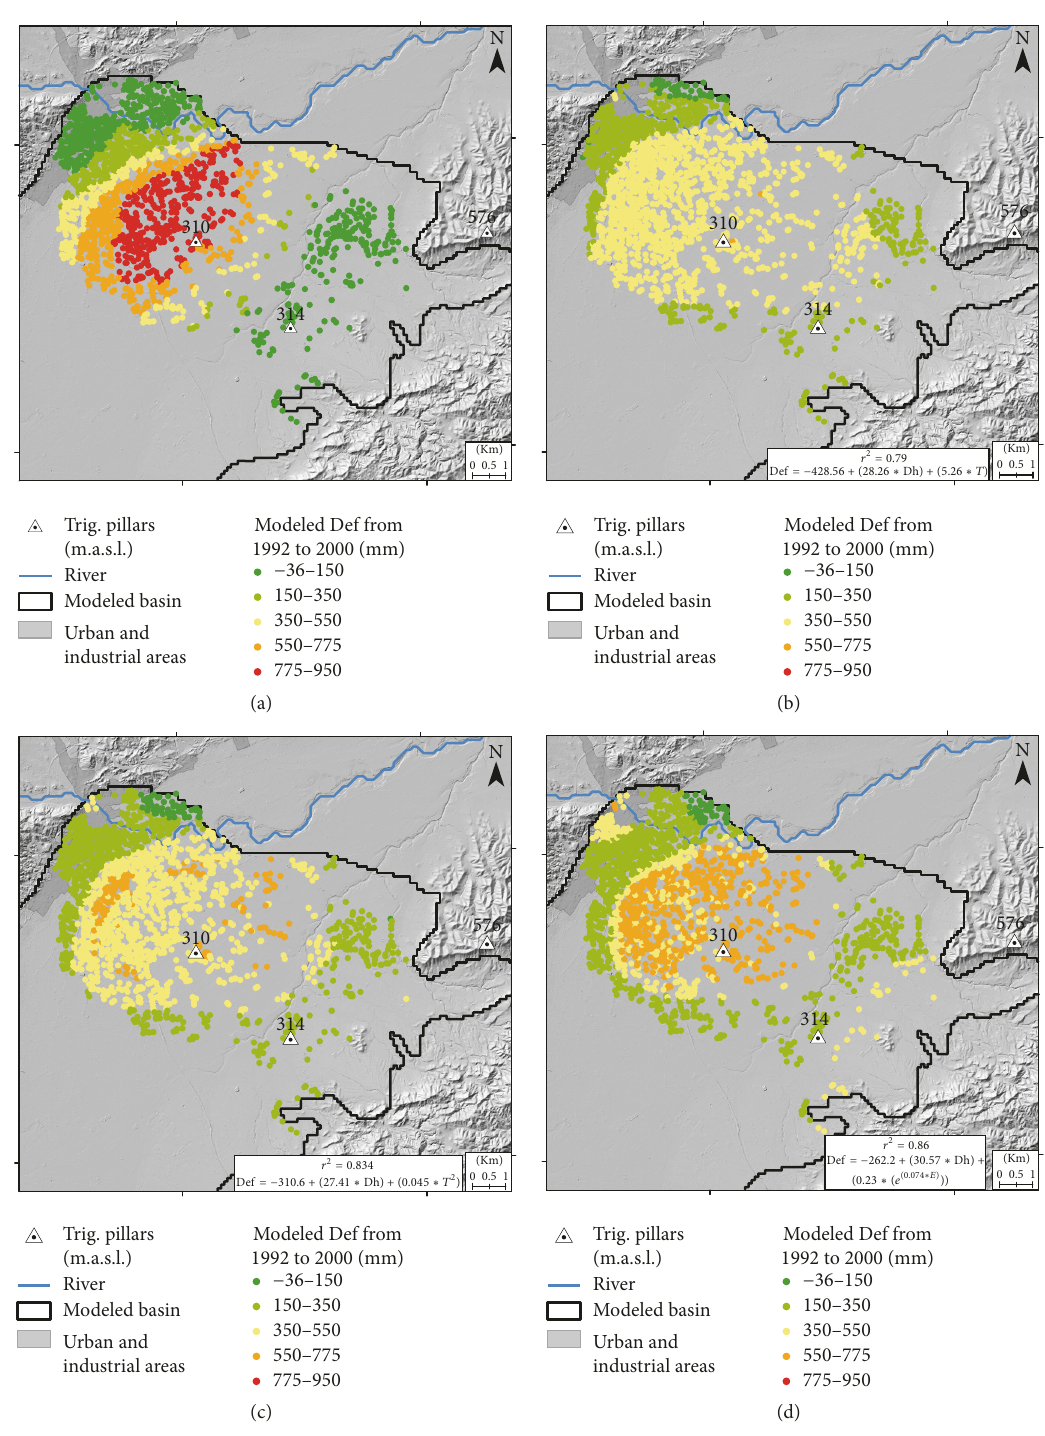
Figure 10: Results of the surface deformation modeled for the ERS period (1992–2000). (a) SAR deformation measured from 1992 to 2000. (b) Calculated deformation using a lineal thickness model. (c) Calculated deformation using a quadratic thickness model. (d) Calculated deformation using an exponential thickness